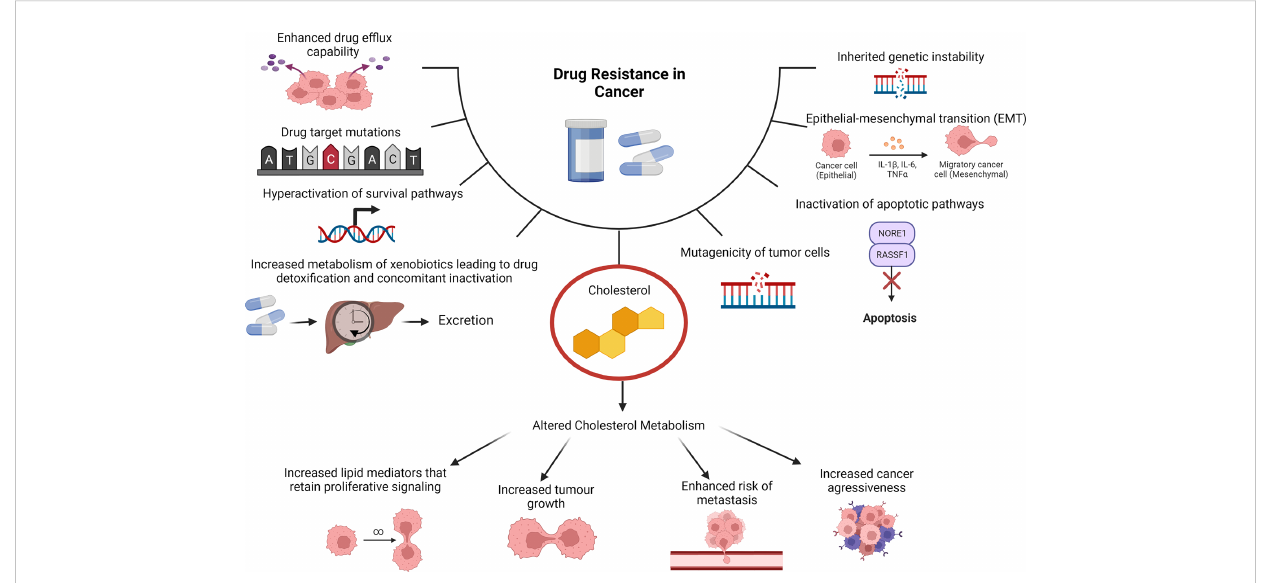
FIGURE 1 Cholesterol as a Contributing Factor to Drug Resistance. Molecular mechanisms of drug resistance in cancer include tumors having enhanced drug ef fl ux capabilities, drug target mutations, hyperactivation of survival pathways, increased metabolism of xenobiotics leading to drug detoxi fi cation and concomitant inactivation can cause drug resistance in cancer. Additionally inherited genetic instability, epithelial- mesenchymal transition (EMT), inactivation of apoptotic pathways and mutagenicity of tumor cells. Cholesterol is also a contributing factor due to altered cholesterol metabolism that can cause increased lipid mediators that retain proliferative signaling, increased tumor growth, enhanced risk of metastasis and increased cancer